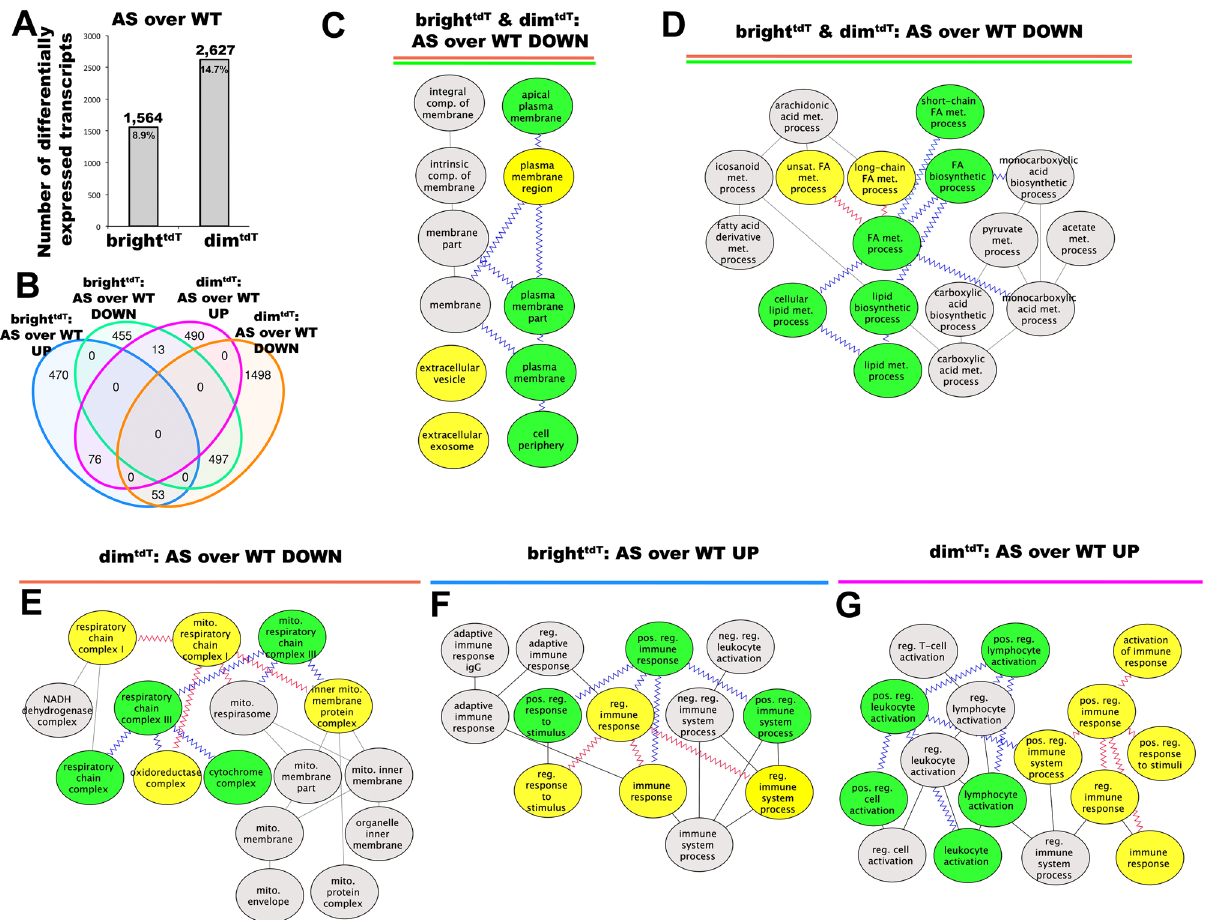
Figure 5. Transcriptional profiling and pathway enrichment analysis for dim tdT and bright tdT subpopulations in AS relative to WT. ( A ) Bar graphs showing the number of genes with differential expression and associated percentages in bright tdT GEC in AS compared to bright tdT GEC in WT and dim tdT GEC in AS compared to dim tdT GEC in WT mice. ( B ) Venn diagram comparison of gene expression, where each of the four circles represents a set of genes differentially expressed in AS GEC subpopulations relative to their WT counterparts; (blue and purple circles denote genes upregulated, while green and orange circles denote genes downregulated in bright tdT and dim tdT respectively in AS over WT). Numbers depicted in the intersections between circles represent the numbers of genes that are commonly up or down regulated in those groups. ( C–G ) Directed acyclic graphs of GO terms based on pathway enrichment analysis of subsets shown in Venn diagram in ( B ) showing the 497 transcripts commonly downregulated in both dim and bright GEC with significant enrichment in extracellular vesicle activity ( C ) and lipid metabolimics ( D ), the 1,498 transcripts downregulated in